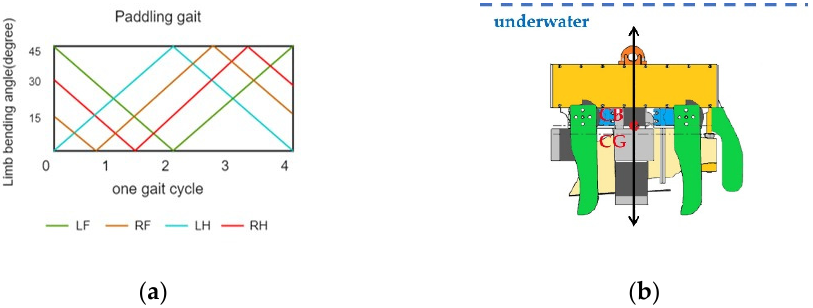
Figure 9. Analysis of a walking cycle: ( a ) limb motion in a walking cycle; ( b ) floating body stability.